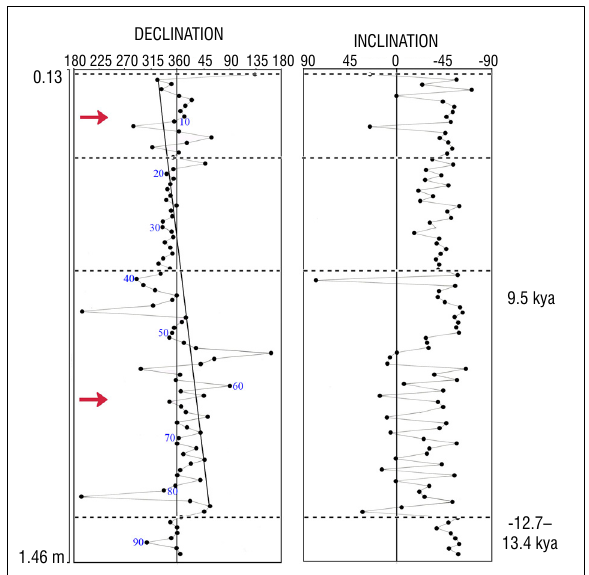
Figure 6: Stratigraphic plots of the declination and inclination profiles from Rose Cottage Cave. The more conspicuous long direction departures are depicted between dashed lines and pointed with an arrow. The numbering of the samples in the declination magnetogram is indicated every 10 specimens.